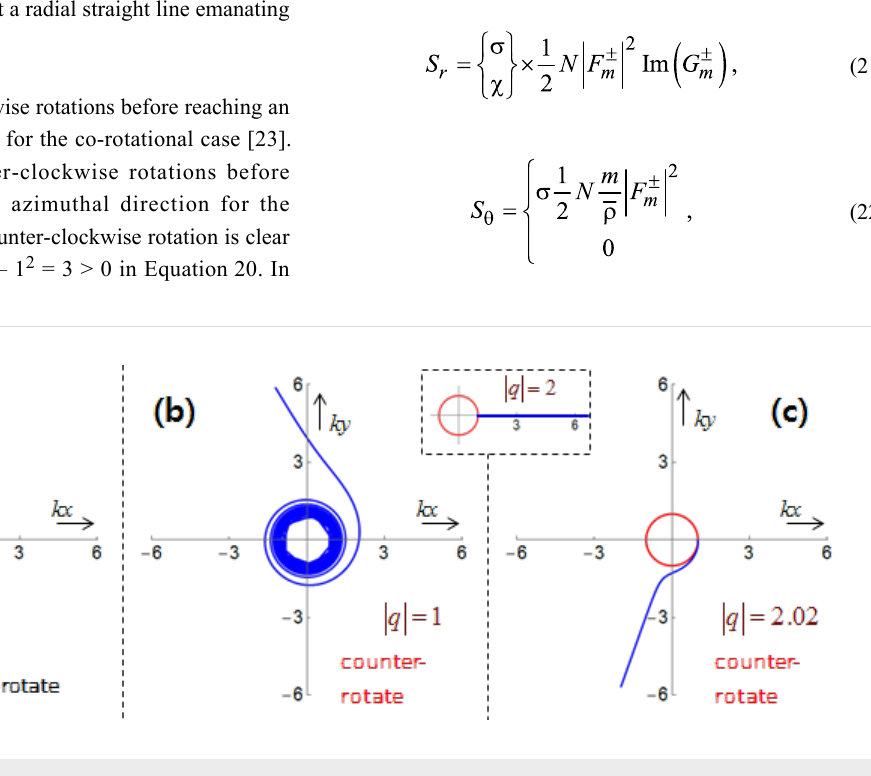
Figure 6: Trajectories of in the ( kx , ky )-plane. (a) The co-rotational case. (b) The counter-rotational case with | q | = 1. (inset) The counter-rotational case with | q | = 2. (c) The counter-rotational case with | q | =